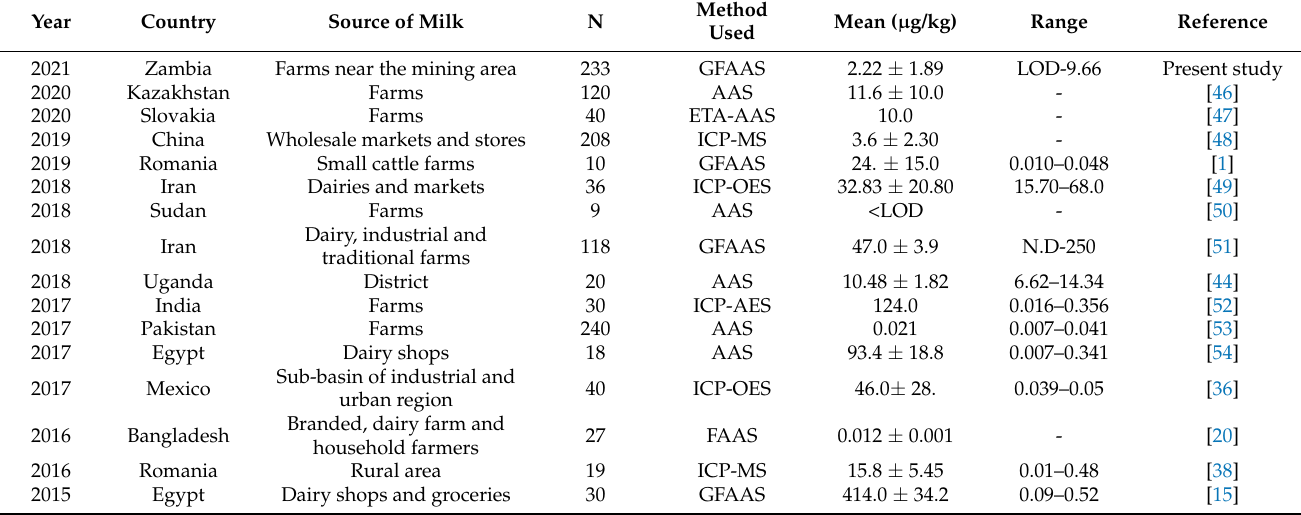
Table 2. Lead levels in cow milk from various countries in recent five years